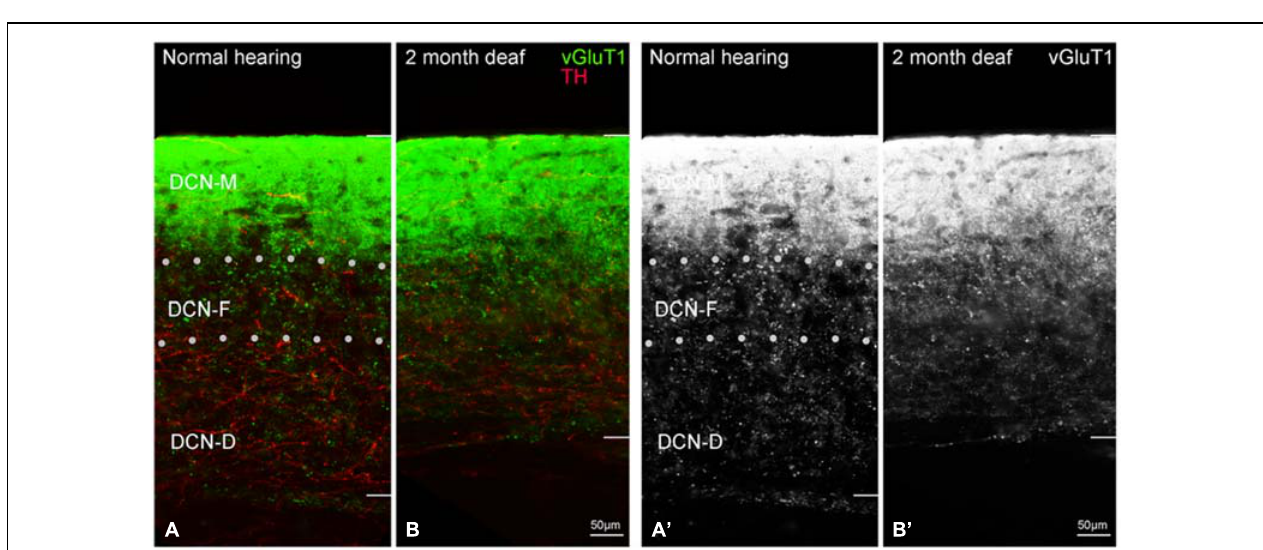
FIGURE 9 | Vesicular Glutamate Transporter 1 (green) is found in the anteroventral cochlear nucleus (AVCN) with a distribution largely distinct from TH (red). In normal hearing animals labeling for VGLUT1 is primarily localized to large glutamatergic terminals (A,A’) forming axosomatic ring structures throughout the nucleus (A,B) . While VGLUT1